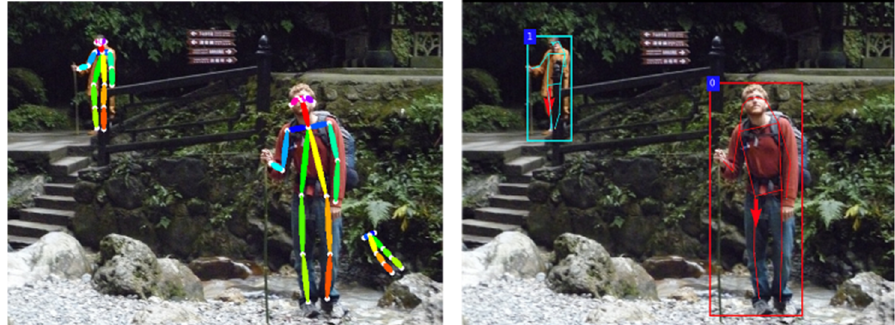
Figure 17. Examples of human pose estimation results generated by OpenPose [29] (left) and the proposed model (right).